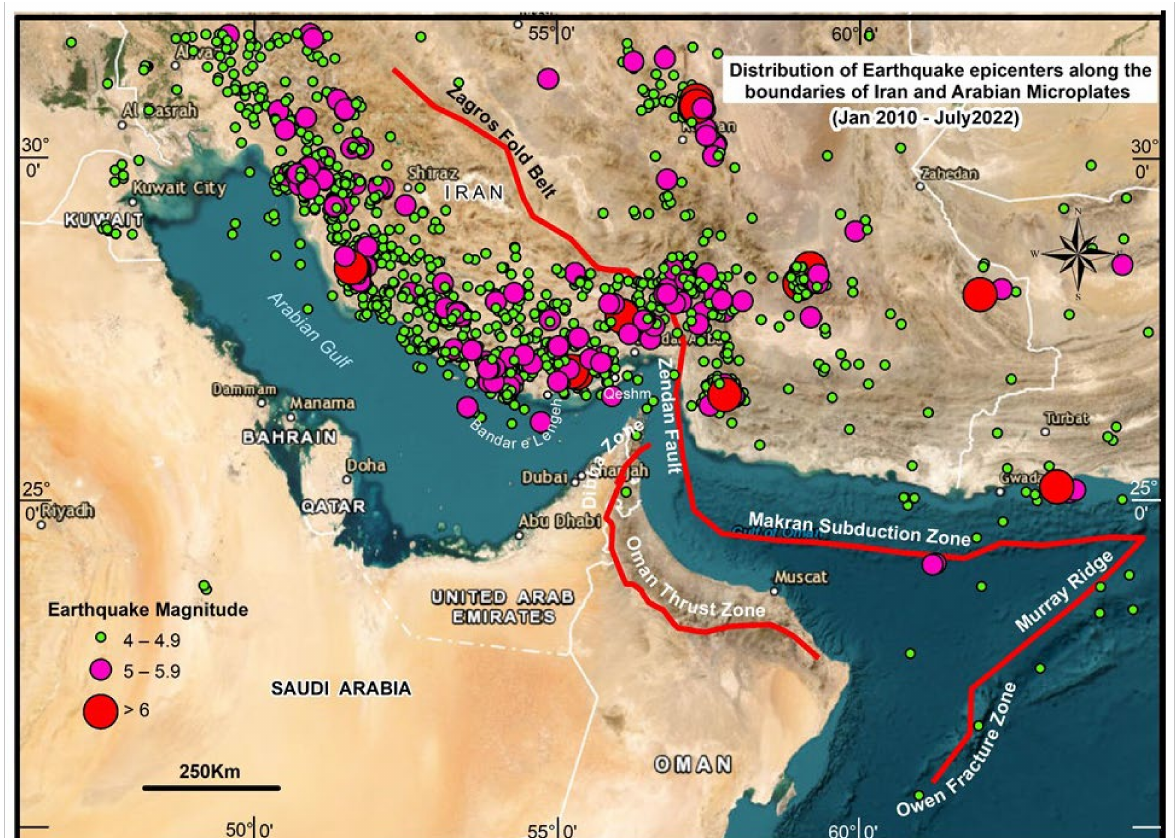
Figure 9. Distribution of earthquake epicenters along the boundaries of Iranian and Arabian Mi- croplates (compiled from George Pararas-Carayannis, 2006, [134]; Jamal A. Abdalla and Azm S. Al-Homoud, 2004,